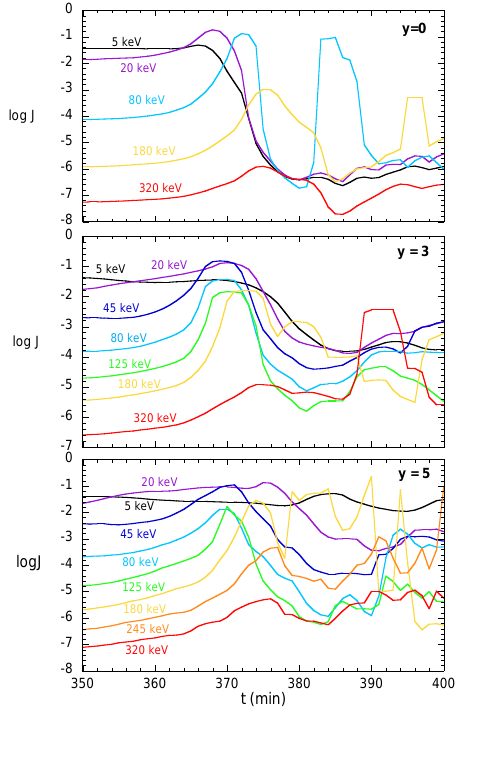
Fig. 8. O + fluxes in the earthward direction as a function of time for various energies at x =− 10 ,z = 0 and three locations in y . The fluxes are calculated using initial kappa distributions (see text).